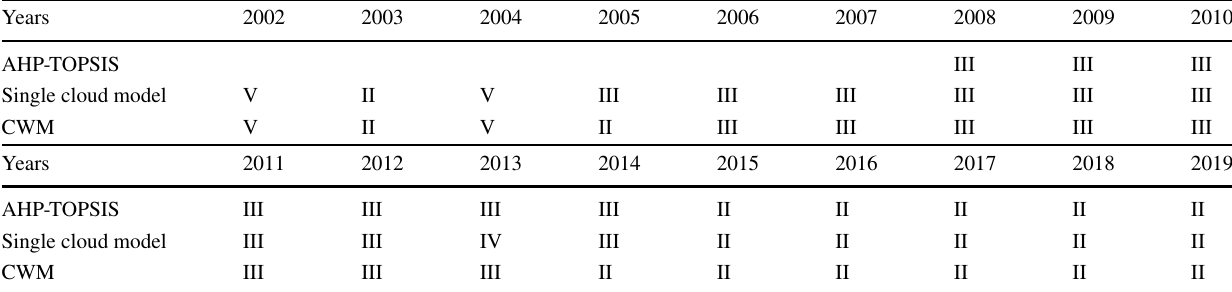
Table 4 Comparison between different methods Years